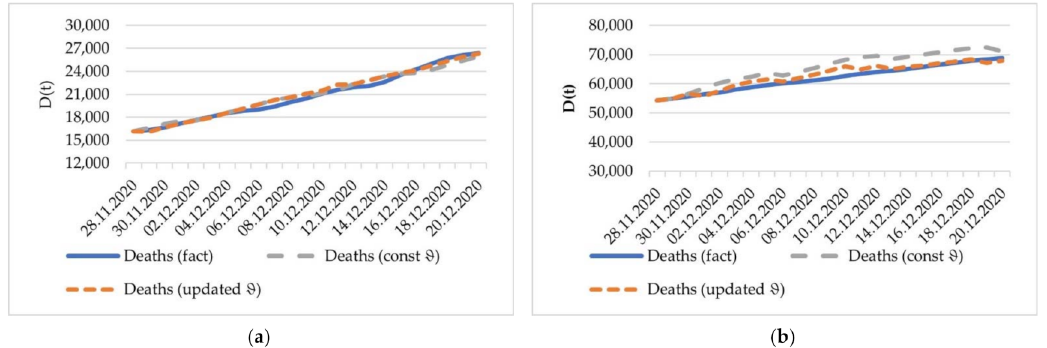
Figure 16. Dynamics of D ( t ) , the actual and calculated trajectories for the interval of 1 to 20 December 2020, in a stationary case and with the updated values of ϑ ( t ) , in ( a ) Germany and ( b ) Italy. For Germany, the value of ϑ ( t ) = 18 days was used in the summer 2020 forecast.